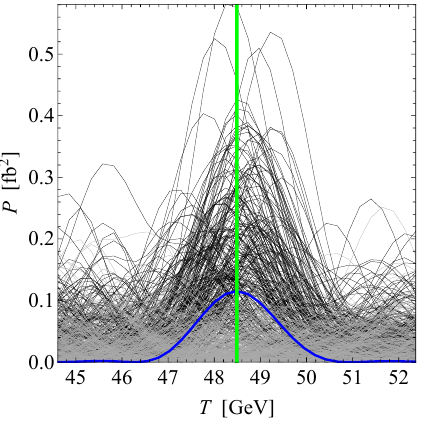
Figure 16 . Left: the signal+background curve (red) is (cid:12)t to a non-oscillating function (green), which is then subtracted to leave just the oscillations (pink). The original oscillations are shown in blue. Right: the power spectrum of the extracted oscillations (pink) vs. the original one (blue).